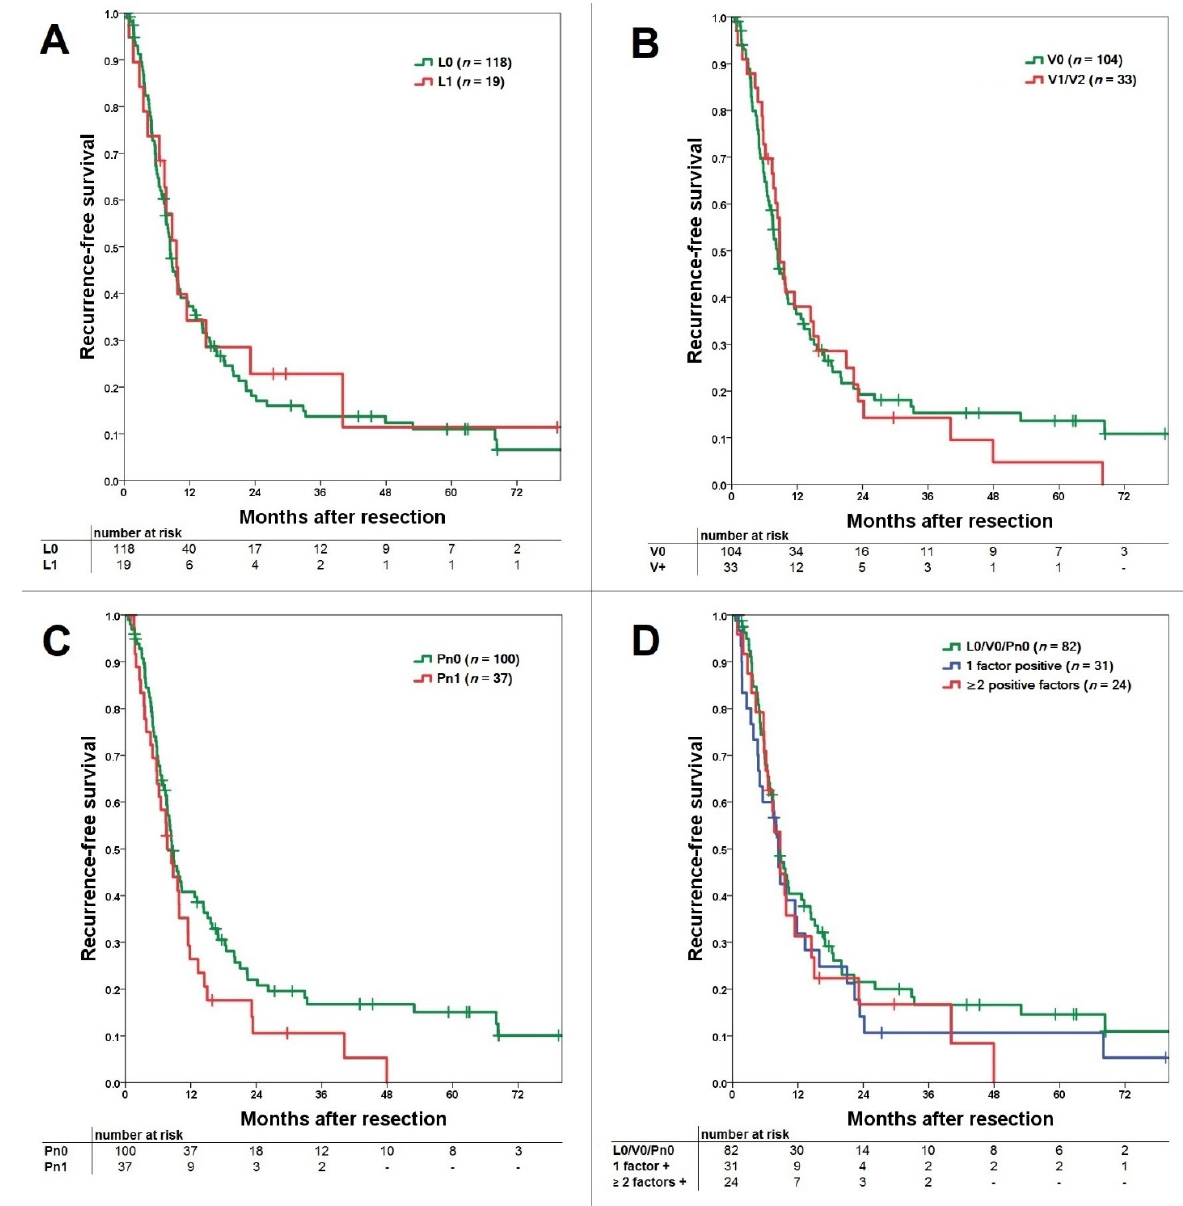
Figure 2. ( A ) Comparison of recurrence-free survival for lymphangioinvasion with comparable survival for the L0 and L1 group ( p = 0.673). ( B ) Comparison of recurrence-free survival for vascular invasion with comparable survival for the V0 and V+ (V1/V2) group ( p = 0.818). ( C ) Comparison of recurrence-free survival for perineural invasion with better survival for the Pn0 over the Pn1 group without reaching significance ( p = 0.091). ( D ) Comparison of recurrence-free survival for L0/V0/Pn0 versus 1 positive factor and ≥ 2 positive factors groups ( p = 0.525). In subgroup comparison, no difference can be shown for L0/V0/Pn0 vs. ≥ 2 positive factors ( p = 0.414) and 1 positive factor vs. ≥ 2 positive factors ( p =